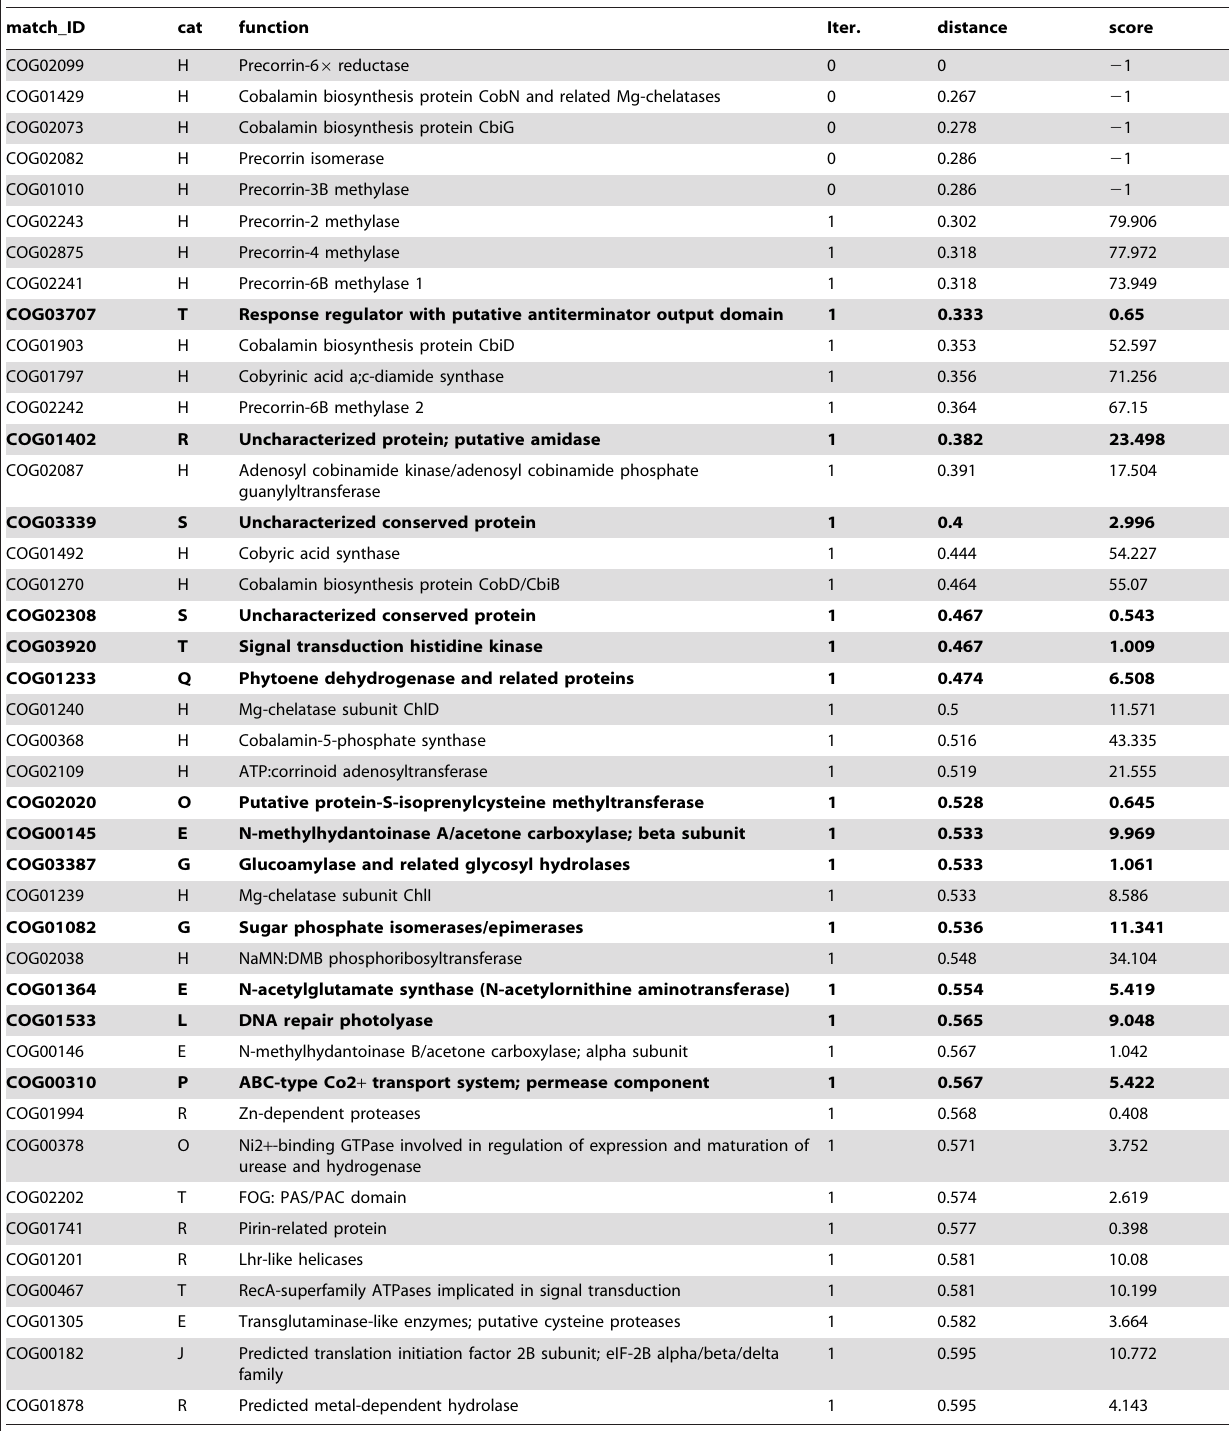
Table 2. Psi-square search results using COG02099 as the